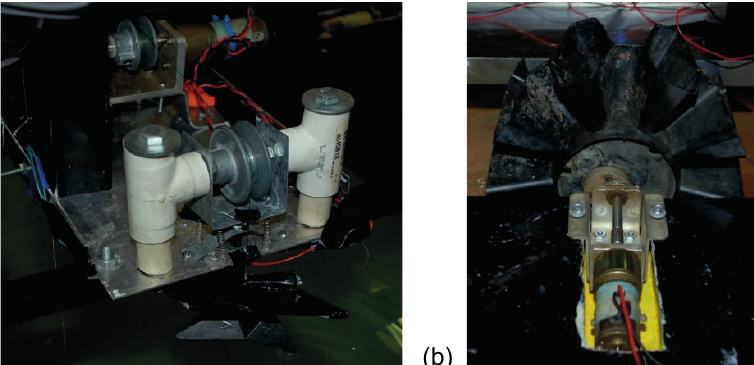
Fig. 2 (a) Assembly of depth measuring device onto aluminium frame for placement on foam pontoons. A metal plate attached to two triangular fishing weights totalling 0.45 kg is lowered off the end of the platform into the water. (b) The